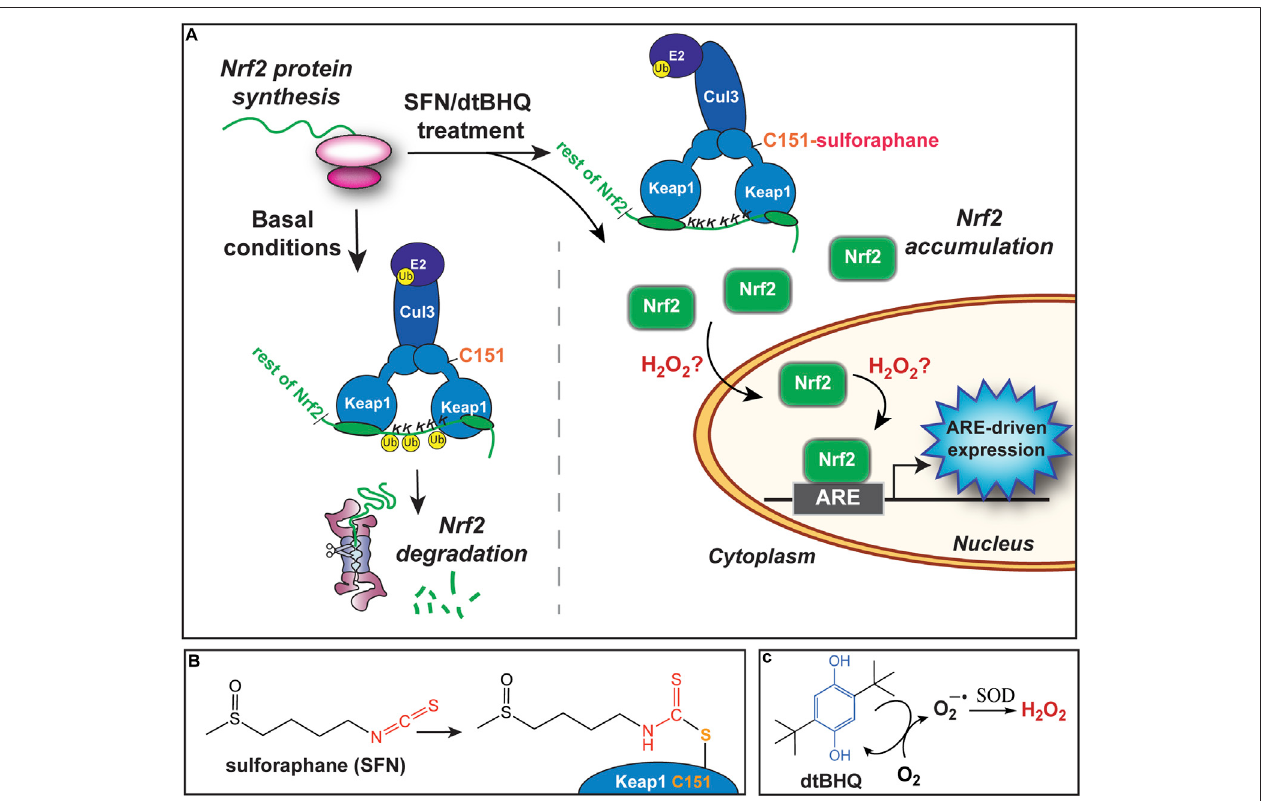
FIGURE2| Activation oftheNrf2/AREpathway bysulforaphaneand dtBHQ. (A) Nrf2proteinisconstitutively synthesized. Underbasalconditions,Nrf2istargeted for ubiquitination and degradation by the Keap1 protein, which forms a bridge between Cul3 and an E2 ligase and Nrf2, positioning Nrf2 lysines for ubiquitination. Upon treatment,sulforaphanemodi fi esKeap1C151,alsoshownin (B) ,alteringtheKeap1-Cul3conformationandpreventingubiquitinationofNrf2lysines.Newlysynthesized Nrf2 accumulates. Subsequently, Nrf2 translocates to the nucleus and binds to copies of the ARE upstream of cytoprotective genes. The inclusion of dtBHQ generates H 2 O 2 , also shown in (C) , which acts downstream of Nrf2 protein accumulation, possibly by increasing nuclear translocation or enhancing Nrf2 ’ s induction of ARE-drivengeneexpression.PossiblemechanismsarefurtherdescribedintheDiscussion. (B) Thestructureofsulforaphaneatleft,andinconjugationwithKeap1C151 at right. (C) The structure of dtBHQ, which redox cycles to donate electrons to dioxygen and generate superoxide. Superoxide dismutase (SOD) converts this to hydrogen